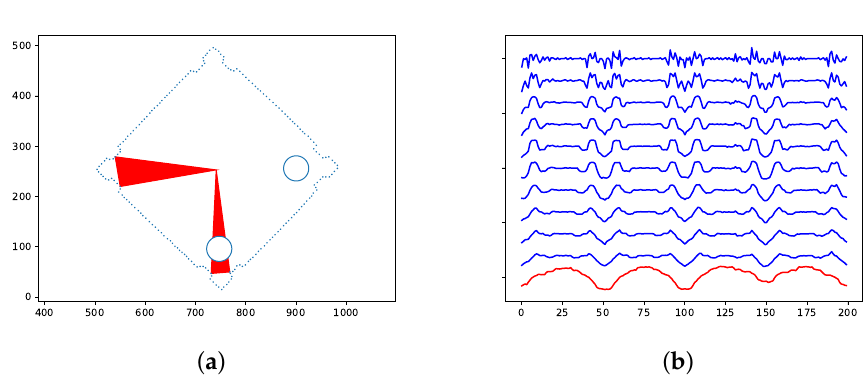
Figure 6. Extension of the TAR descriptor. ( a ) the sampled contour and holes with examples of triangle areas describing the inner object area. ( b ) the TAR descriptor with our extension (the bottom line). It is quite visible that the standard TAR values contain four same segments, whereas the extension two plus two. Thus alignment is uniquely determined.